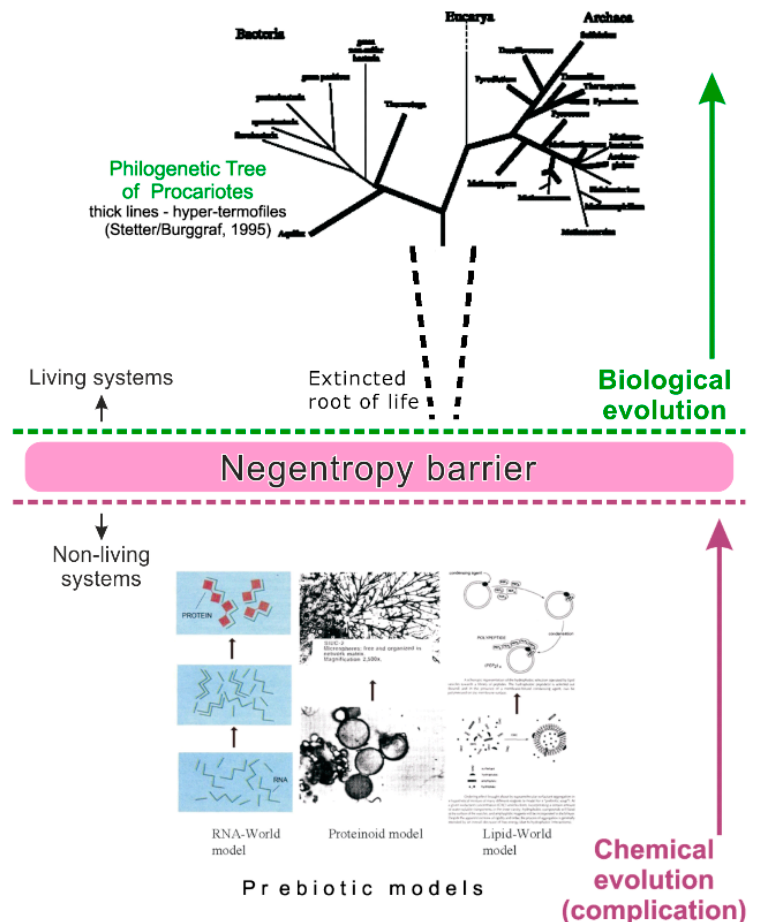
Figure 1. The thermodynamic (‘negentropy’) barrier between chemical and biological